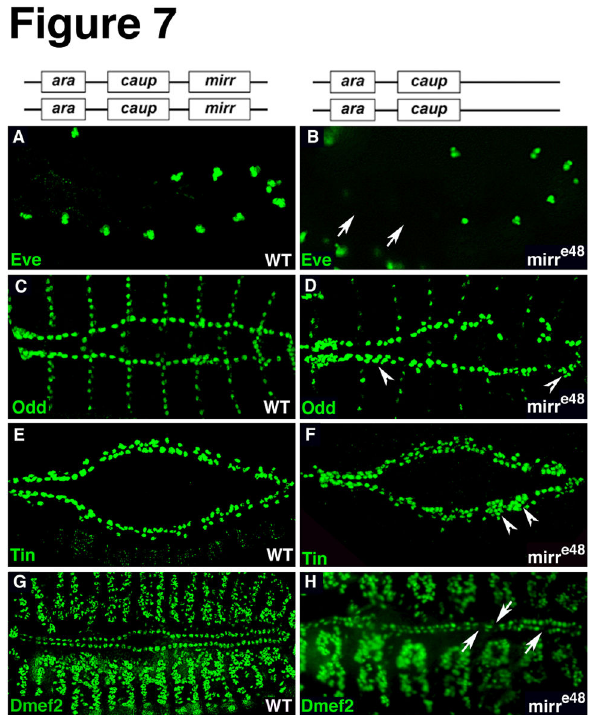
Figure 7. Heart phenotypes in embryos mutant for mirr . (A, B) mirr mutants have a reduced number of Eve clusters (arrows). (C, D) The number of Odd-expressing pericardial cells is increased in mirr mutants (arrowheads). (E, F) mirr mutants are characterized by an increased number of Tin-positive cells (arrowheads). (G, H) Myocardial Dmef2- expressing cells are slightly reduced in mirr mutants (arrows). Quantification of the phenotypes is included in the bar graphs shown in Figure 6 Q-T.